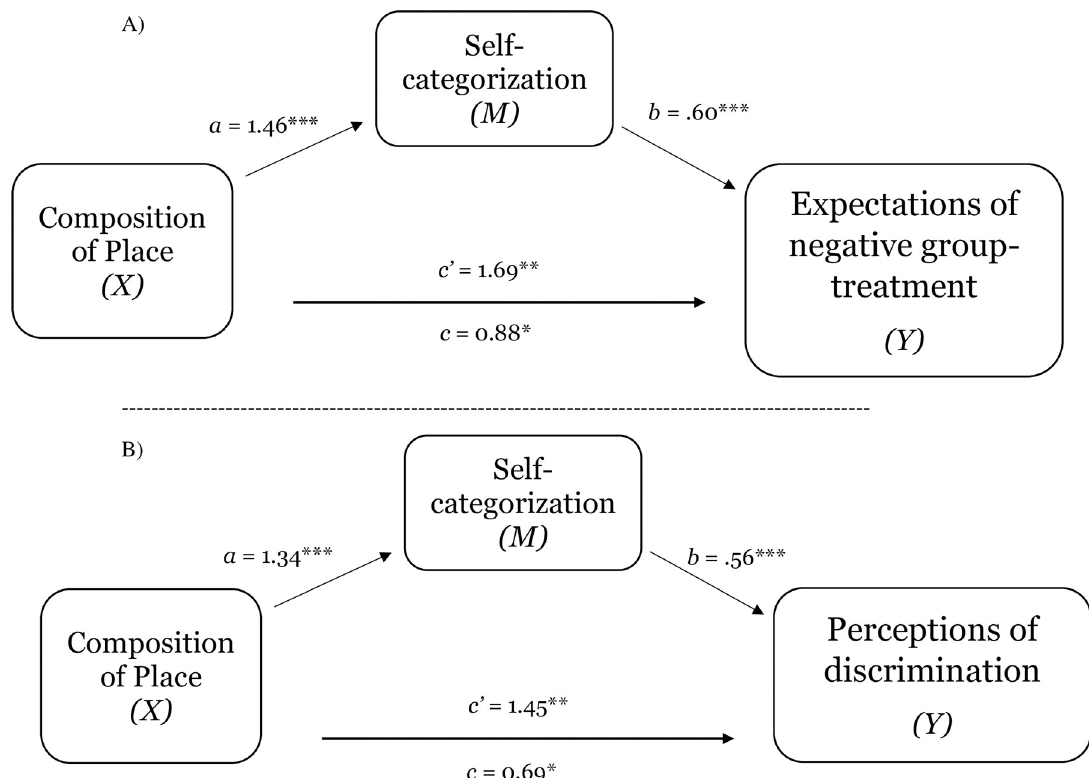
Fig 7. Test of the mediating effect of self-categorization on the relation between composition of place and expectations of negative group-based treatment (Panel A) and perceptions of discrimination (Panel B) in Study 2a. Notes: � p < .05, �� p < .01, ��� p < .001.